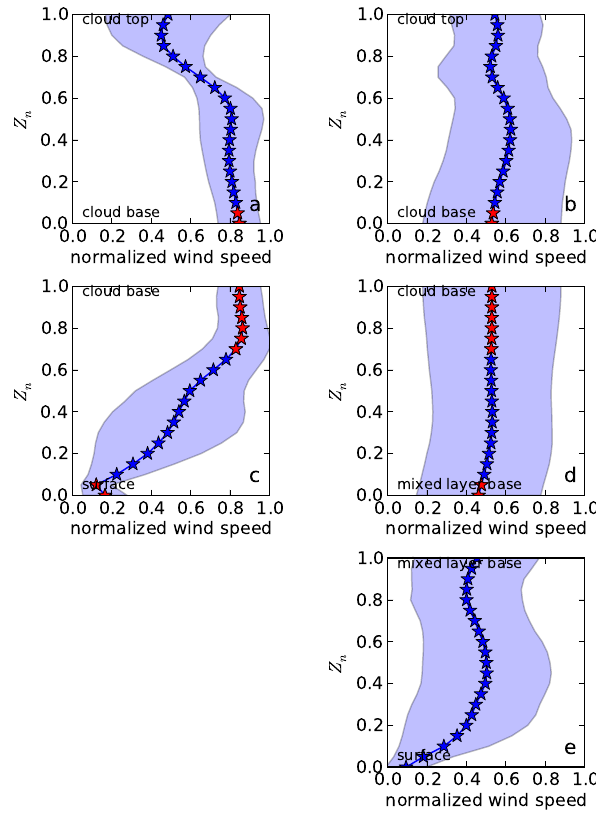
Fig. 13. Mean (starred line) and standard deviation of radiosonde wind speeds normalized by maximum wind speed between surface and cloud top and normalized in height by layer boundaries: (a–b) cloud base ( z n = 0) to cloud top ( z n = 1), (c–d) sub-cloud mixed- layer to cloud base and (e) surface to mixed-layer layer base; phys- ical height boundaries are labeled on the left of each panel. Left panels are sub-sampled for coupled surface–cloud systems and right panels for decoupled surface–cloud systems between 25 and 30 Au- gust. Red stars indicate mean values between coupled and decou- pled cases that are statistically significantly different at the 90% confidence interval following a double-sided Student t